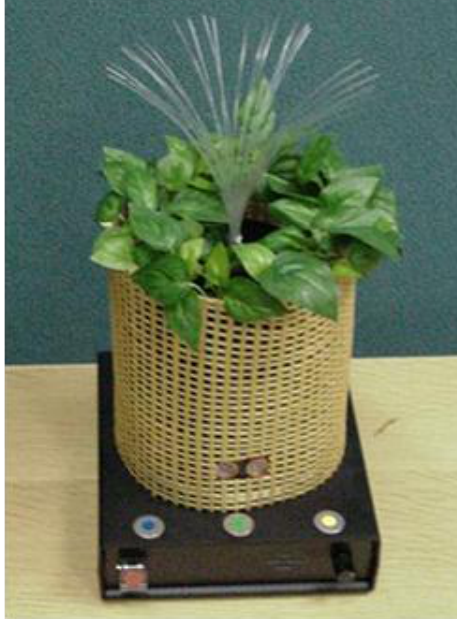
Figure 4. A “family planter” terminal on the Botanicalls network; such terminals are connected to each other through a network; the system detects human motion and shares such events with other terminals in real time, the optical fibers at the top of the terminal lighting up to indicate when a human is detected, then rotating to orient to the human’s movements; these exchanges are designed to blend in with the everyday life of its users [12].